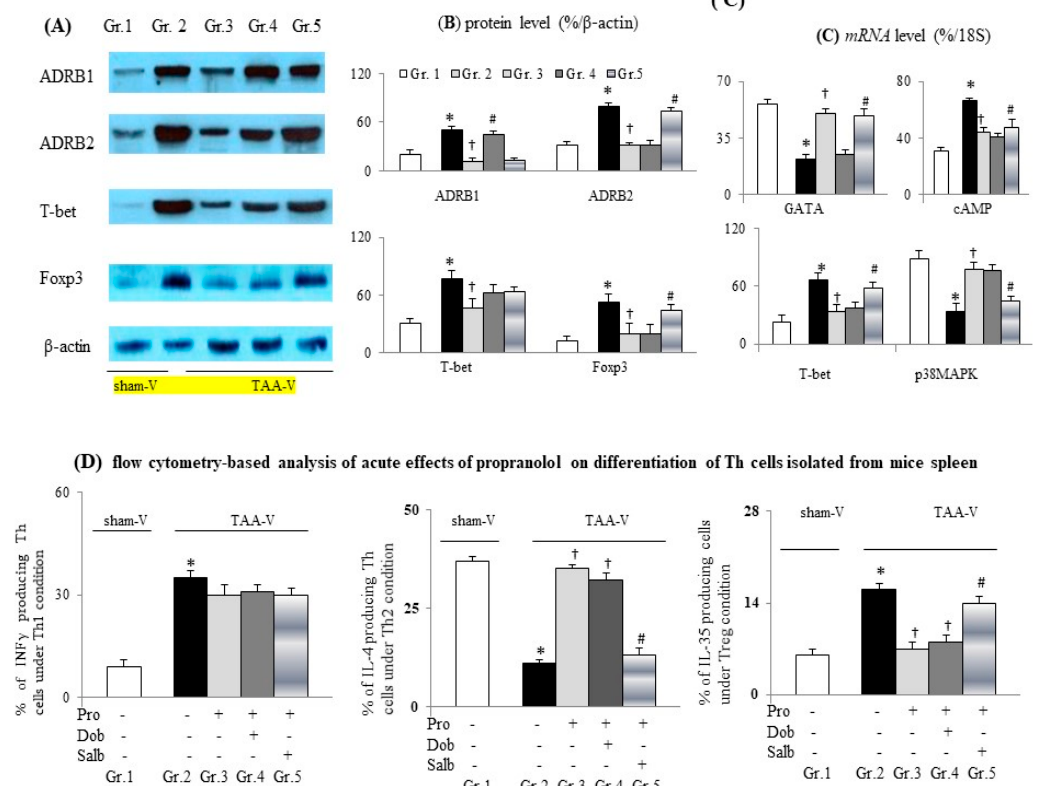
Figure 7. Acute propranolol incubation inhibited Treg-conditioned di ff erentiation and restored Th2-conditioned di ff erentiation of Th cells isolated from the spleens of cirrhotic mice. ( A , B ) Representative images and bar graphs of proteins and mRNAs (% / 18S); ( C ) Expressions in cell lysates of Th cells isolated from spleen of sham-V or TAA-V mice; ( D ) Flow cytometry-based intracellular cytokine staining for percentages of Th1 / Th2 / Treg-conditioned di ff erentiation among groups. * p < 0.05 vs. sham-V group; † p < 0.05 vs. TAA-V group.